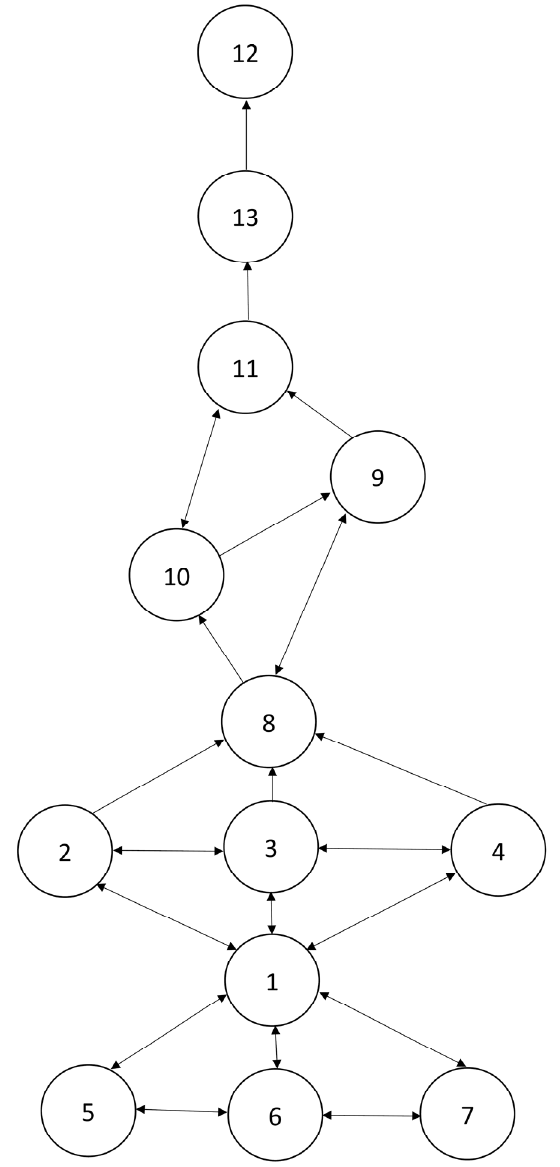
Figure 2. Learning trajectory of counting and arithmetic concepts for girls. Notes: 1 = oral counting from 1 to 30; 2 = one-to-one correspondence counting within 30; 3 = cardinality within 30; 4 = numerical literacy within 30; 5 = sum (under 10) of two numbers; 6 = difference (under 10) between two numbers; 7 = compose and decompose number 10; 8 = forward verbal counting 30 numbers from a specific number within 30; 9 = backward verbal counting from a specific number within 30 to 1; 10 = unknown addend (within 30); 11 = unknown subtrahend (within 30); 12 = unknown summand (within 30); 13 = unknown minuend (within 30).